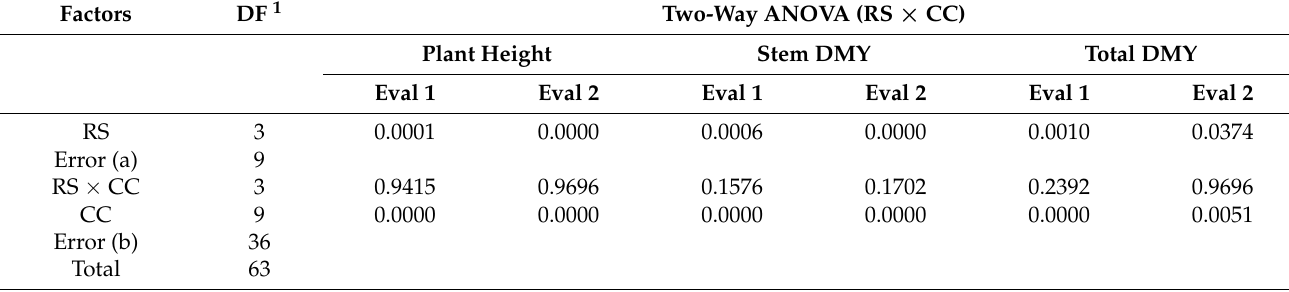
Table 7. The effects of sulla row spacing and cover crops on sulla plant height (cm), stem DMY (t ha − 1 ), and total DMY (t ha − 1 ) in the second year of sulla growth in the 2018–2020 and 2019–2021 growing cycles. Data were pooled across growing